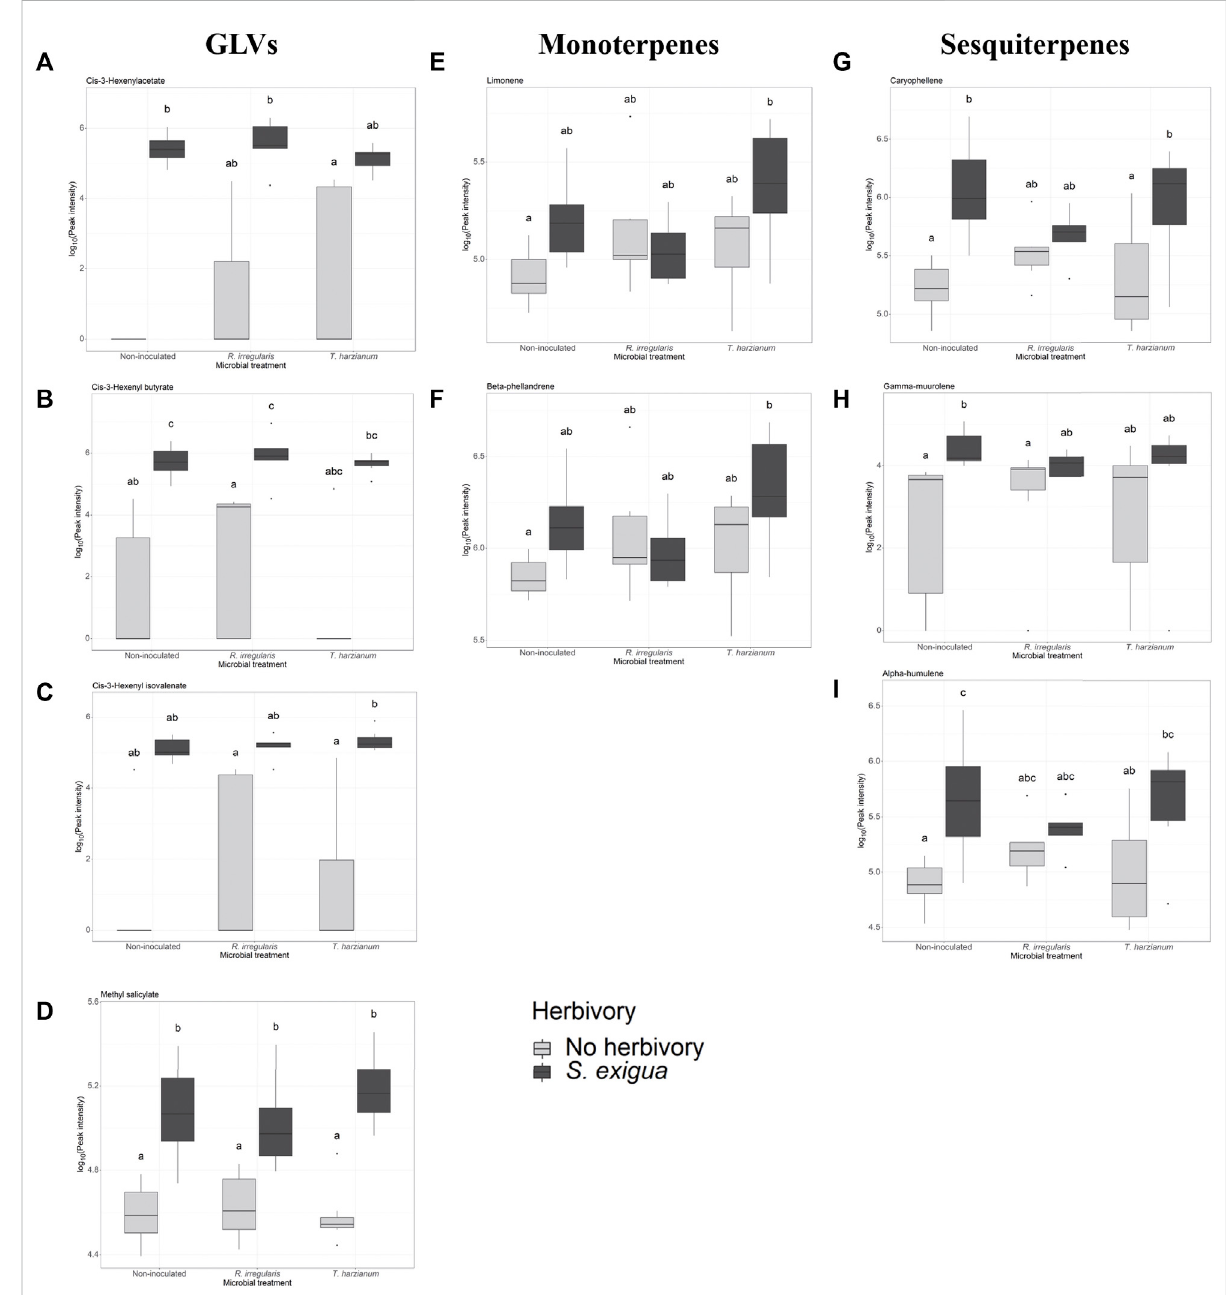
FIGURE 3 Selection ofvolatilecompounds emitted bynon-inoculated and root-inoculatedtomatoplantsnon-infested or infested by Spodoptera exigua larvae for 24 h. The compounds depicted belong to the class of green leaf volatiles (A – C) , methyl salicylate (D) , monoterpenes (E,F) , and sesquiterpenes (G – I) . The compounds shown were selected based on the effect of S. exigua herbivory on their emission. Treatments are: control plants symbolized as Non-inoculated, Rhizophagus irregularis -root inoculated plants symbolized as R. irregularis and Trichoderma harzianum root-inoculated plants symbolized as T. harzianum . Light gray-colored boxplots represent non-herbivore-infested plants and dark gray-colored boxplotsrepresent S.exigua -infestedplants.Signi fi cantdifferencesbetweentreatmentsareindicatedbydifferentlettersafterTukey ’ s posthoc tests after two-way ANOVA: p <